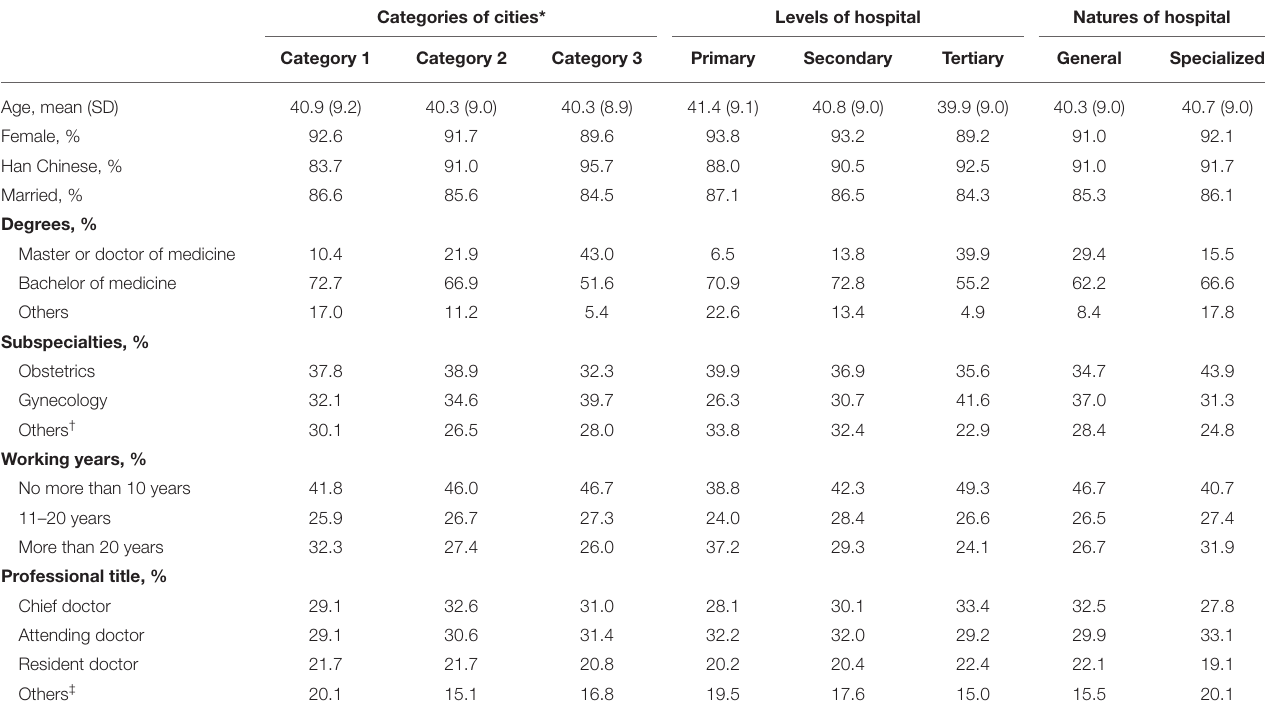
TABLE 1 | Demographics of the